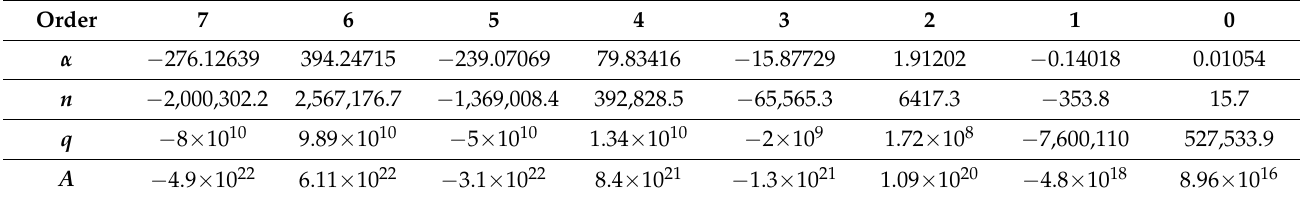
. ε , ( b ) σ − ln Table 1. Coefficients of the polynomials.